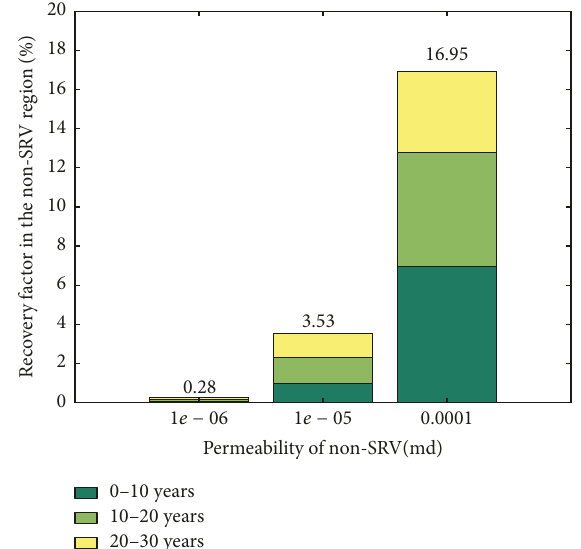
Figure 7: The effect of matrix permeability on the recovery factor in non-SRV